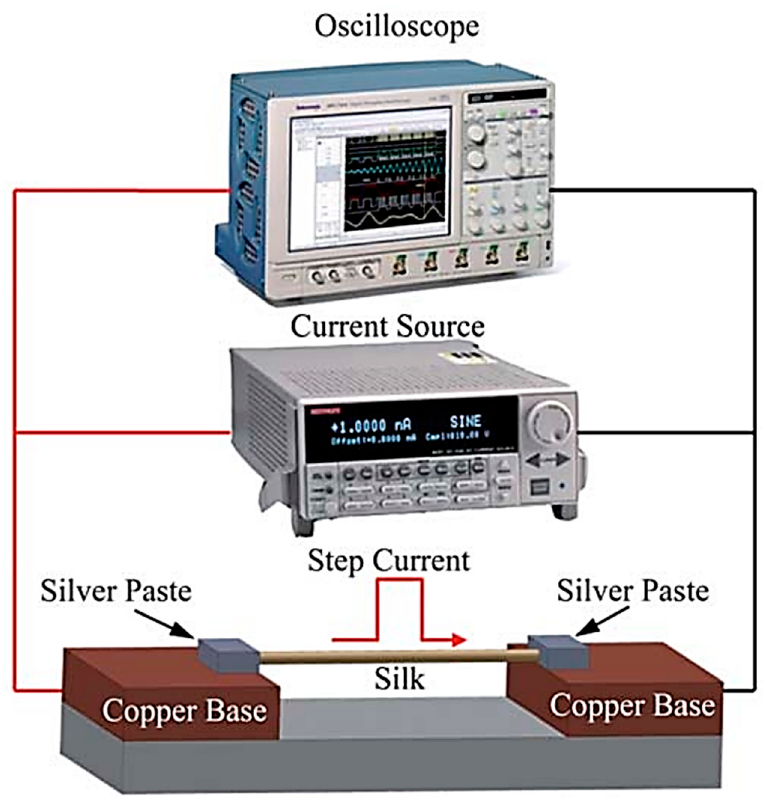
Figure 9. Schematic of the transient electrothermal technique (TET). Reprinted with permission of the Royal Society of Chemistry [64].